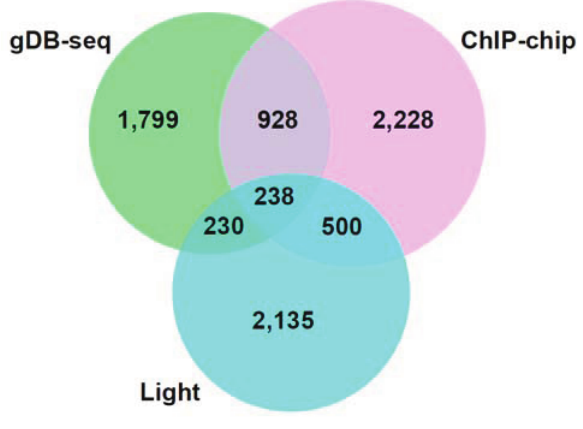
Figure 5. Venn diagram of overlaps between gDB-seq (gDNA binding sequencing), ChIP-chip (Chromatin immunoprecipitation-chip) [11] and light-regulated genes